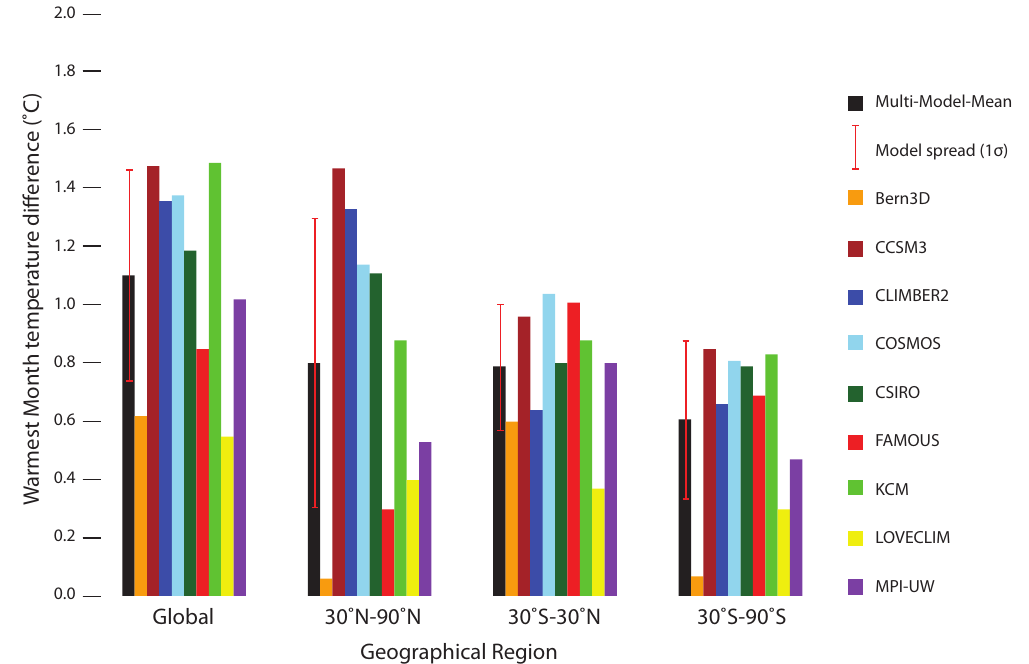
Figure 2. Overestimation of LIG maximum warmth taking into account simulated warmest month temperatures.Differences between the compilation-warmest-periods and the warmest-single-period methods to calculate the simulated LIG thermal maximum warmest month temperature anomalies ( ◦ C). Results are given for four different geographical regions and for MMM temperature differences (black with 1 σ inter-model spread in red) and for the nine individual model runs.